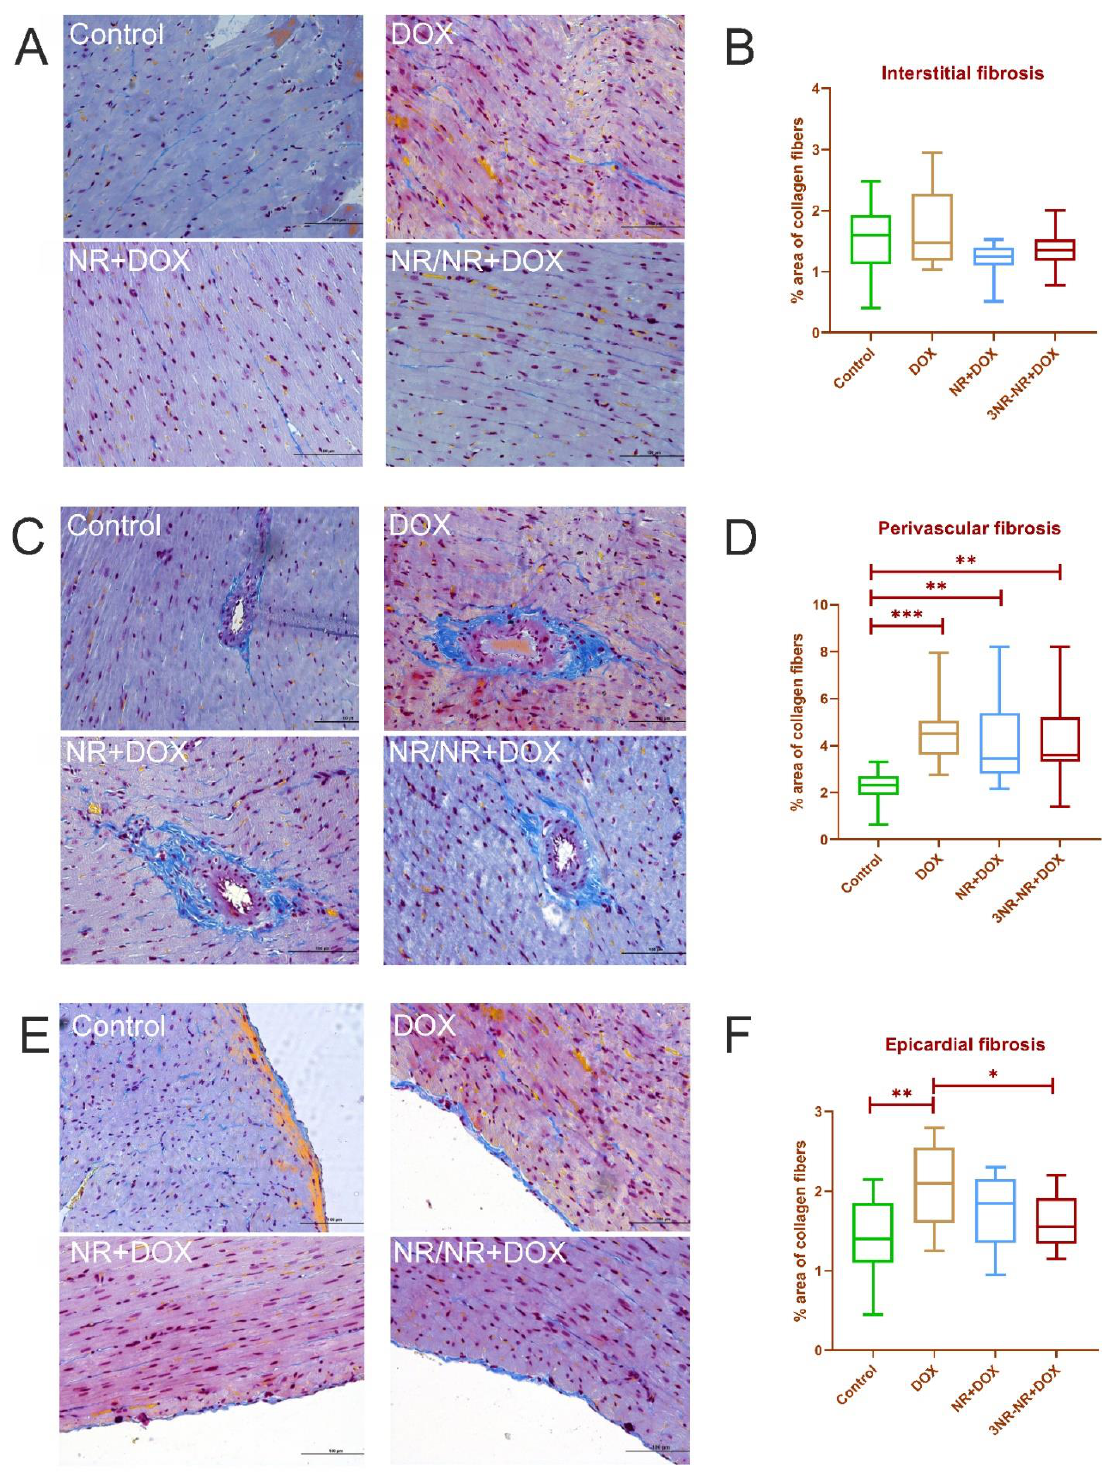
Figure 6. Morphometric values (% area of collagen fibers) in cardiac muscle. ( A , B ) — interstitial fibrosis; ( C , D ) — perivascular fibrosis; ( E , F ) — epicardial fibrosis. Collagen fibers are blue. Staining by Mallory, × 100. * — p < 0.05, ** — p < 0.01, and *** — p < 0.001. Data are presented as median [25%;75%]. Control represents control group (n = 15); DOX represents doxorubicin group (n = 15); NR+DOX represents nicotinamide riboside + doxorubicin group — combined mode (n = 15); and NR/NR+DOX represents nicotinamide riboside/nicotinamide riboside + doxorubicin group— preventive mode (n =